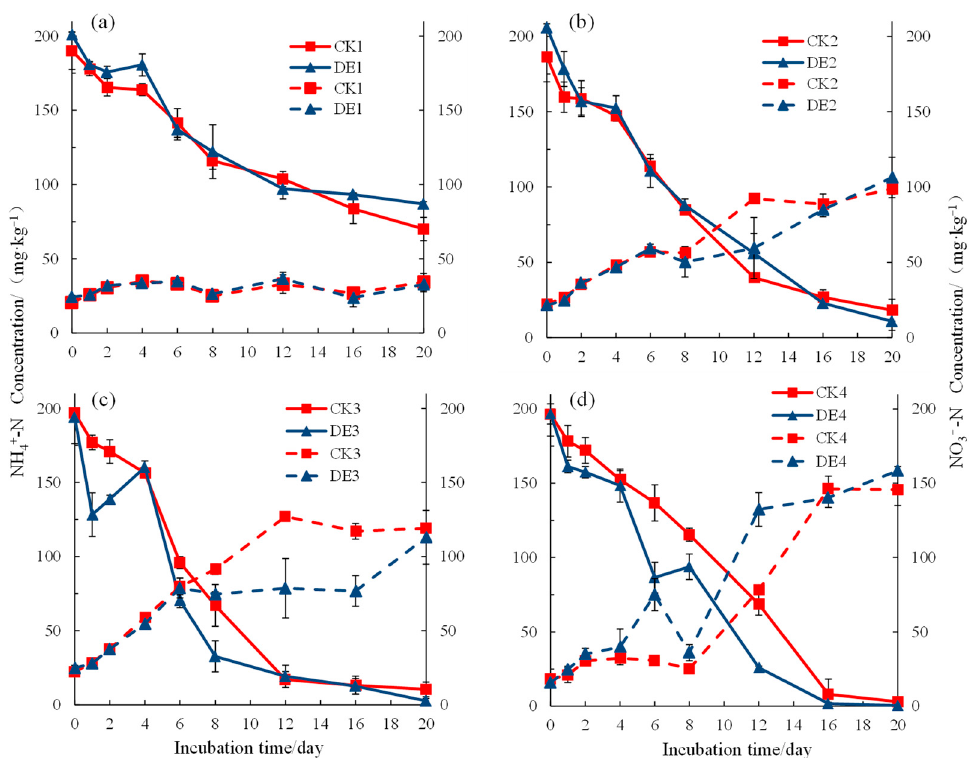
Figure 1. Changes of the soil NH 4+ -N and NO 3 − -N concentrations under different treatments. Note: θ FC , soil water content at field capacity; CK, ordinary water and DE, ionized water, ( a ) 30% θ FC, ( b ) 60% θ FC, ( c ) 100% θ FC, ( d ) 175% θ FC .